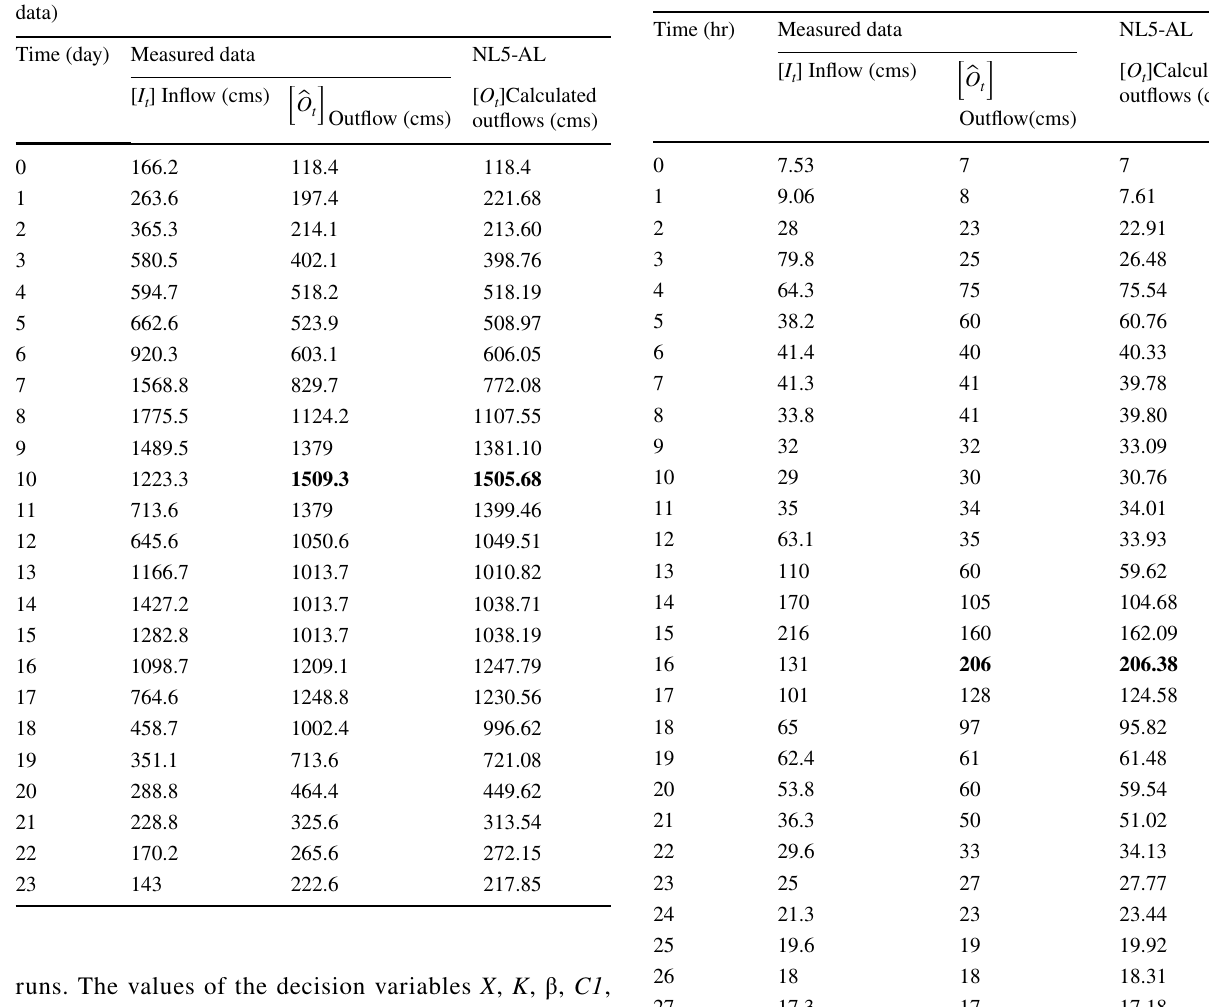
Table 4 Results related to the fourth example (Sutculer flood